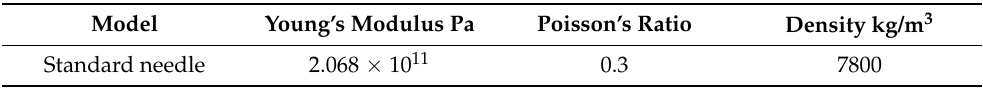
Table 2. Material parameter setting of the standard needle.